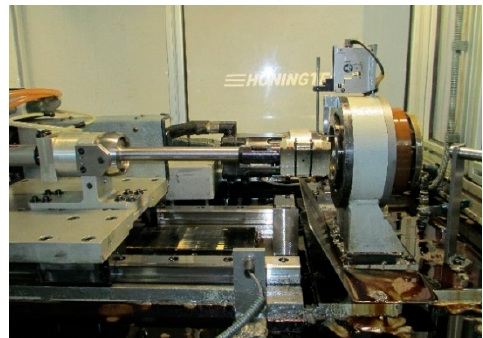
Figure 2. Honing test machine .